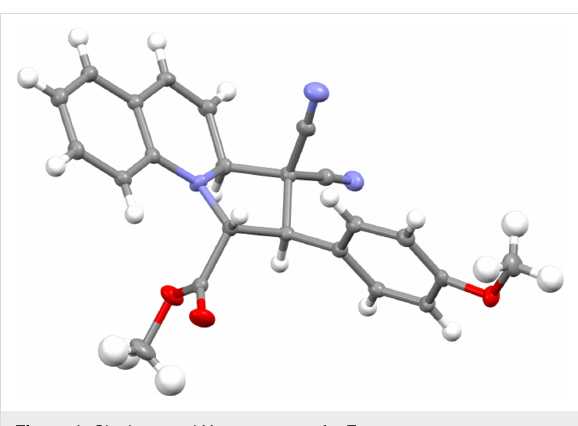
Figure 1: Single crystal X-ray structure for 7c .